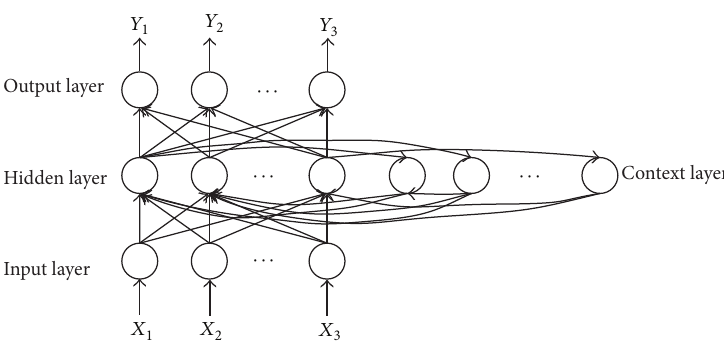
Figure 2: Scheme of a recursive Elman neural network with one hidden